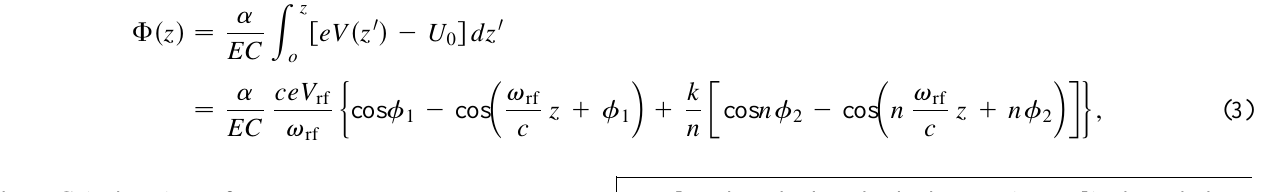
To lengthen the bunch, the harmonic amplitude and phase should be adjusted to cancel the slope of the main rf voltage at the bunch center. The potential well and bunch distri- bution with harmonic voltage and phase adjusted to can- cel the slope of the main rf voltage are shown in Fig. 3a. Shown in Fig. 3b are the potential wells and distributions for the conditions in Fig. 3a except with a 6 0.5 ± phase shift, indicating the sensitivity of the bunch shape and longitudinal centroid position (i.e., synchronous phase) to small variations. The reduction in longitudinal focusing needed for lengthening the bunch is the main reason for this